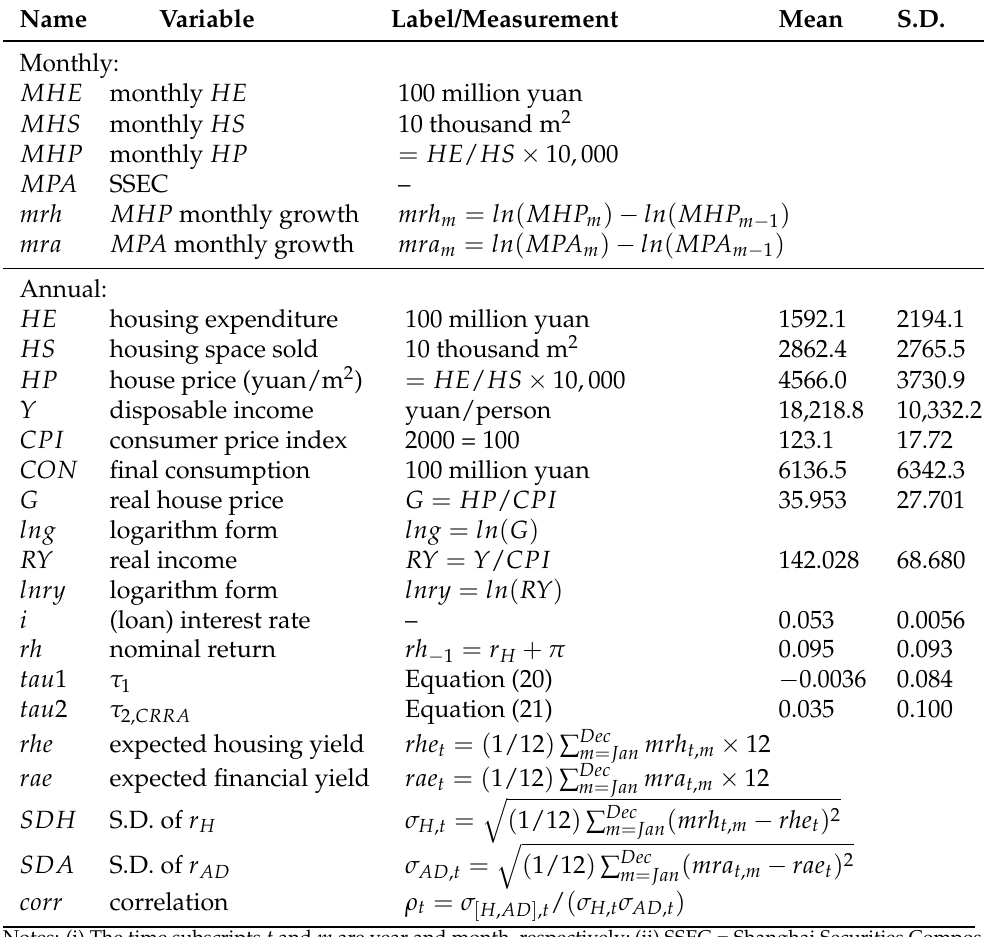
Table 1. Data Description.